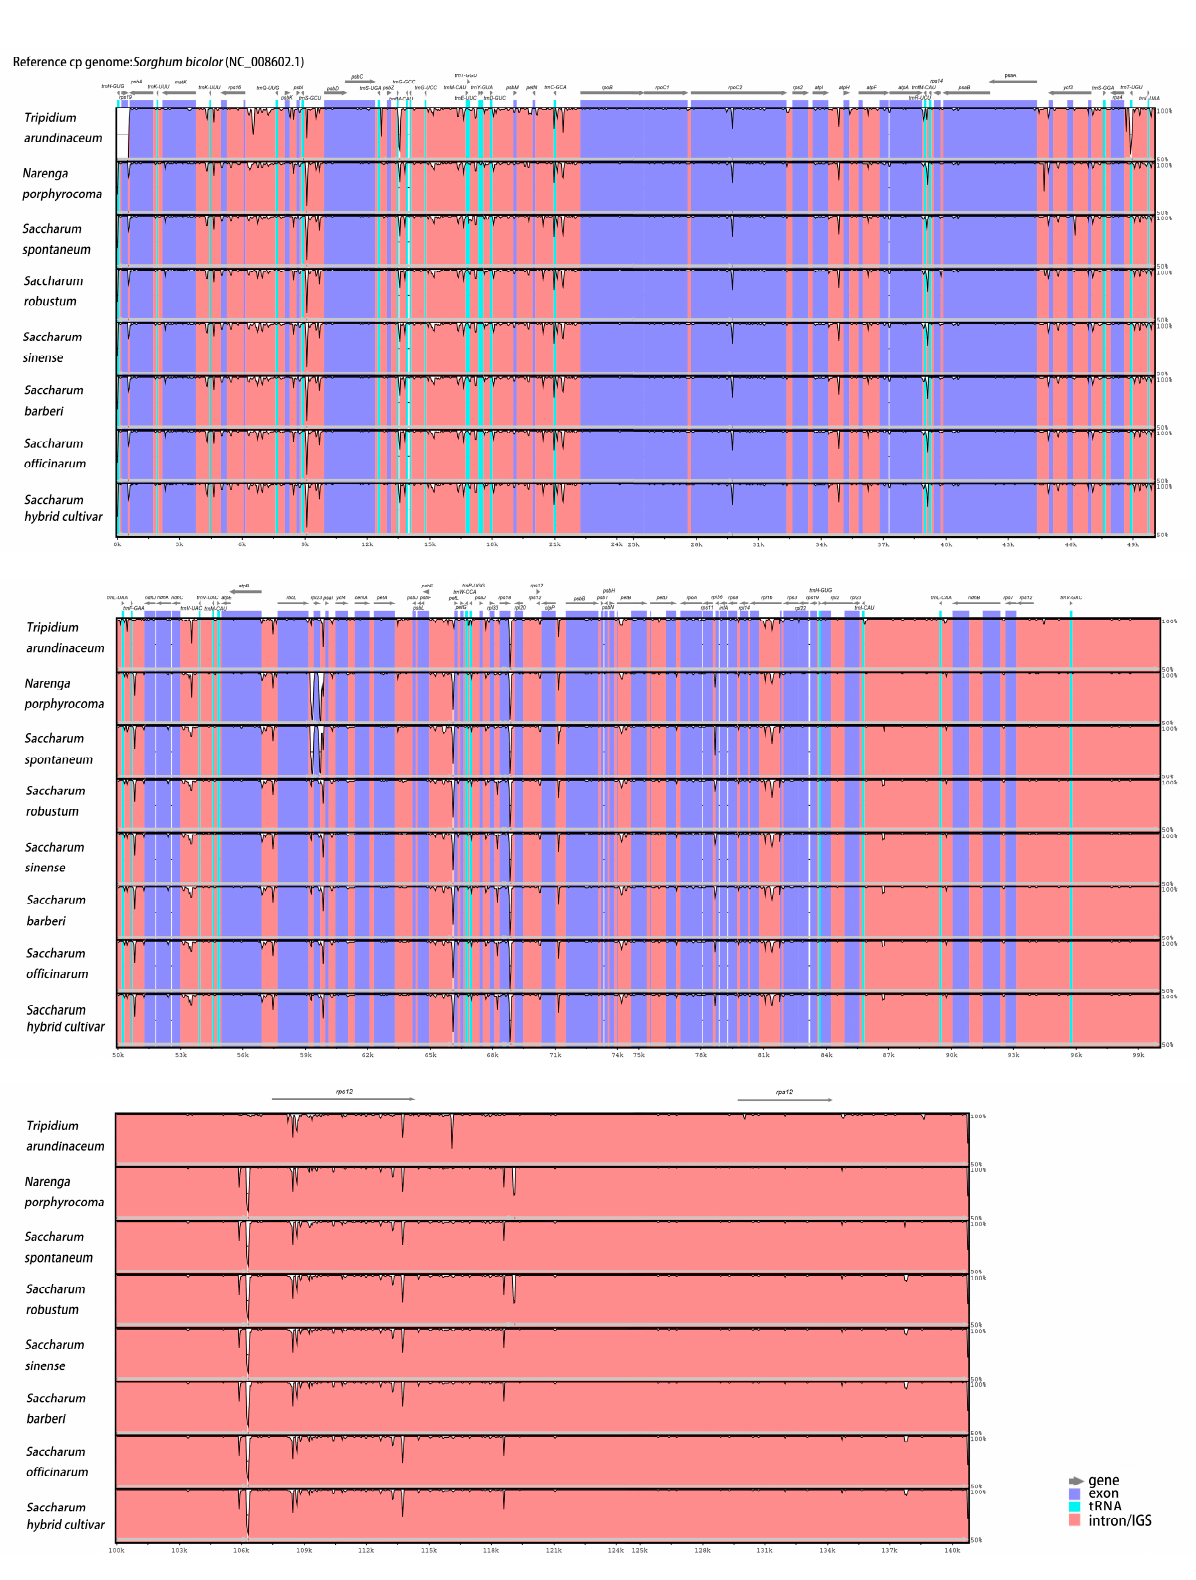
Figure 4. Chloroplast genomes were aligned using the mVISTA program with the annotation of S. bicolor as a reference. The X- and Y-scales indicate the coordinates within chloroplast genomes and the percentage of identity (50~100%), respectively. Gray arrows indicate the direction of transcription of each gene. Annotated genes are displayed along the top. The red block is the intron region, the pearlecent Aqua block is the tRNA region, and the purple block is the CDS